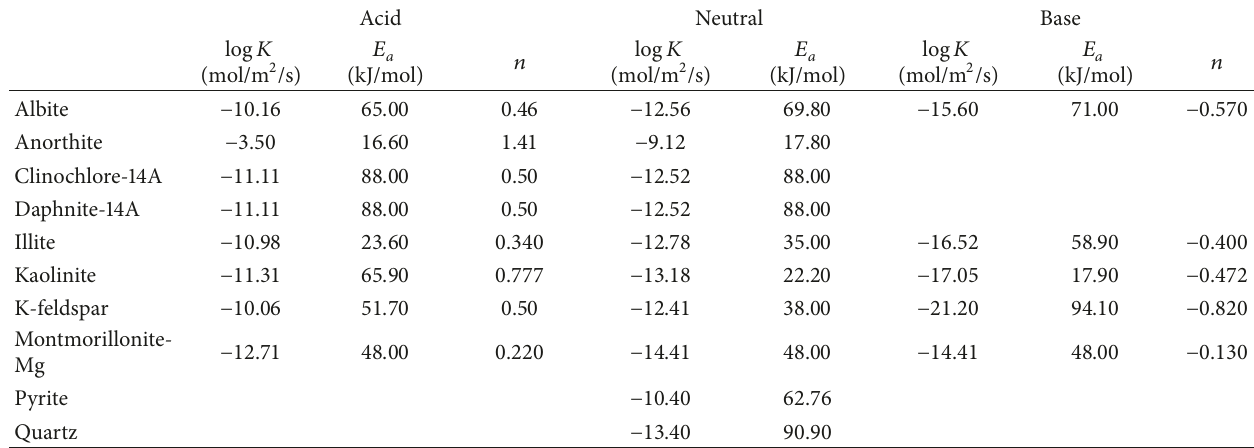
Table 2: Kinetic rate parameters for dissolution/precipitation of minerals used in this